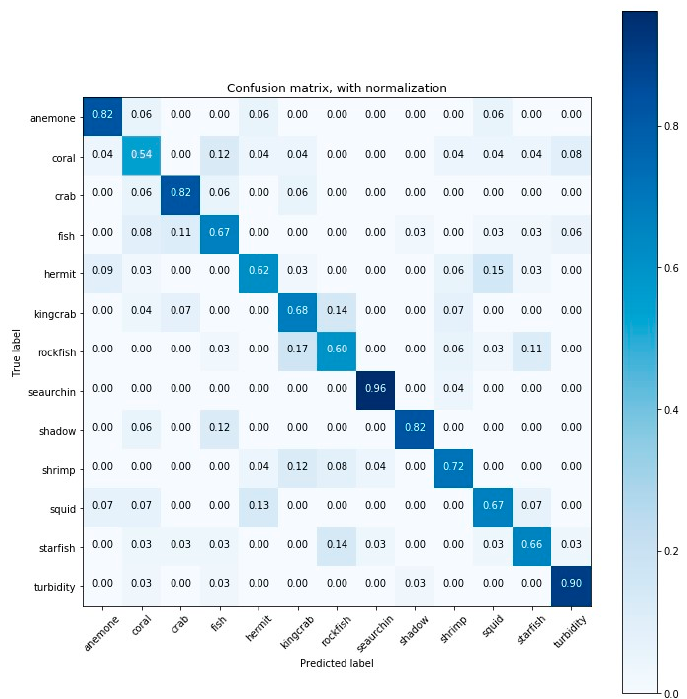
Figure A9. Confusion matrix for the classification results (accuracy) obtained by CNN-2.